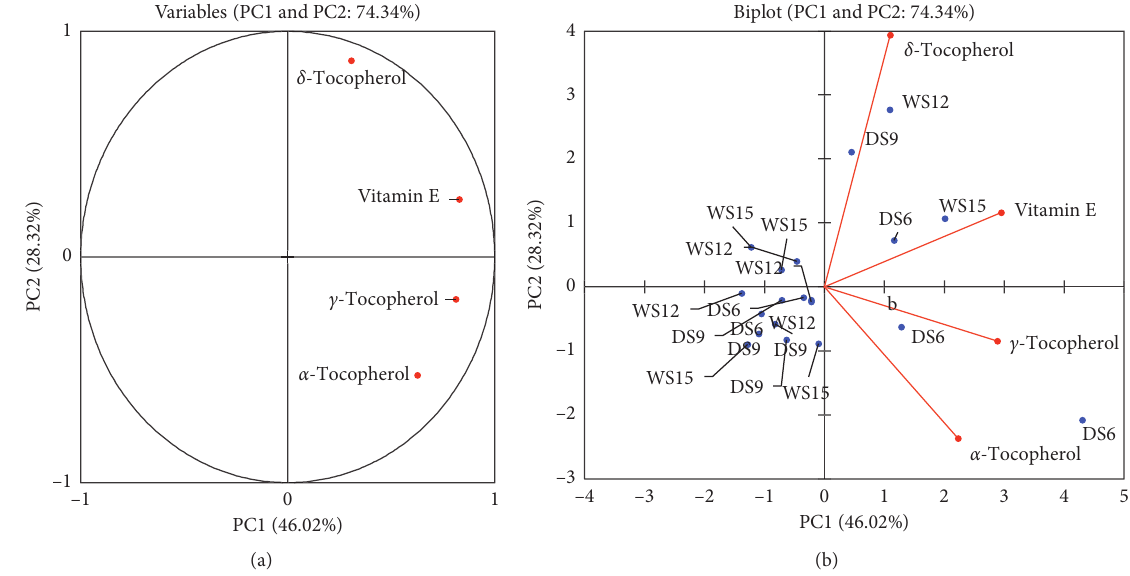
Figure 3: Principal component analysis (PCA) mean showing the relationship among total vitamin E tocopherol isomers and effects of growth stages and seasons on their contents. (a) Correlation between variables and factors and (b) biplot. DS6: dry season at 6MAP; DS9: a dry season at 9MAP; DS12: dry season at 12MAP; DS15: dry season at 15MAP; WS6: b wet season at 6MAP; WS9: wet season at 9MAP; WS12: wet season at 12MAP; WS15: wet season at